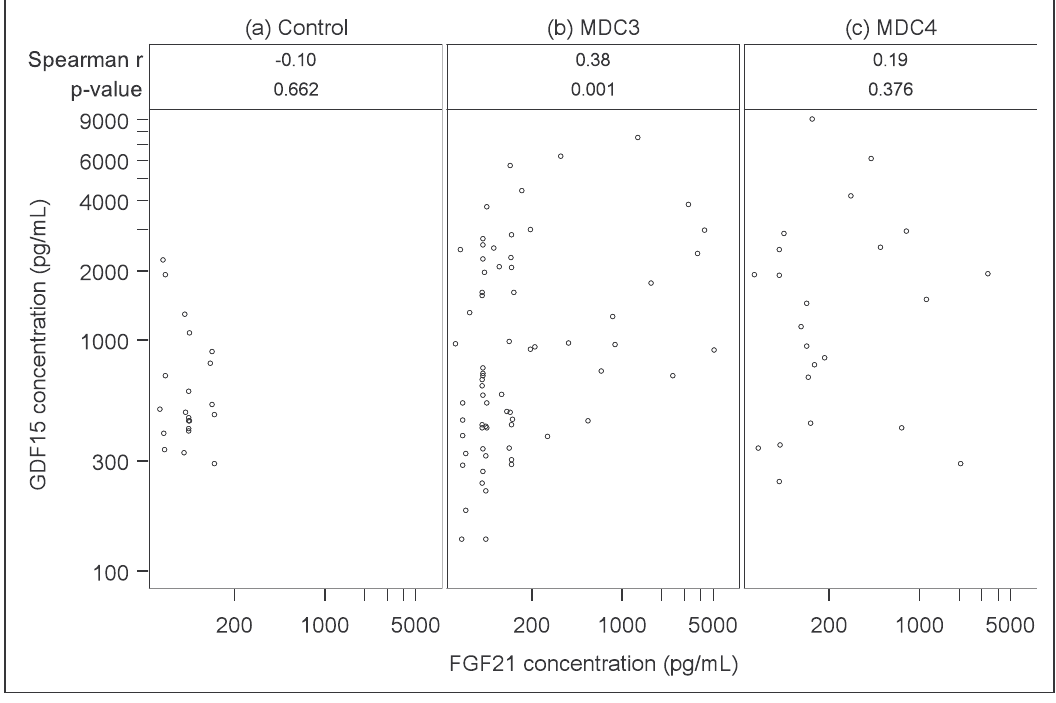
Fig 3. Correlational analyses of FGF21 and GDF15 concentrations by case status. Associations between plasma values for FGF21 and GDF15 are shown for (a) MDC0 controls, (b) MDC3 cases, and (c) MDC4 cases. Spearman’s r coefficients and associated p values for each case status group shown above. FGF21 = fibroblast growth factor 21; GDF15 = growth differentiation factor 15; MDC = mitochondrial disease criteria.